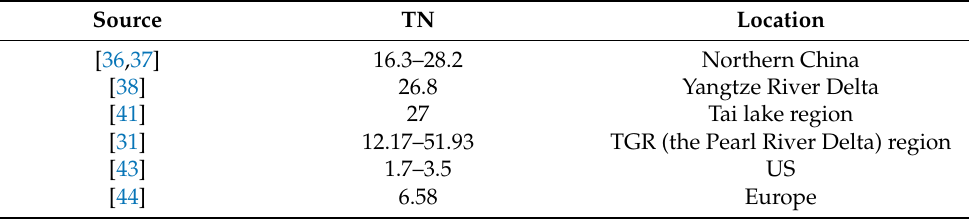
Table 3. Total wet N